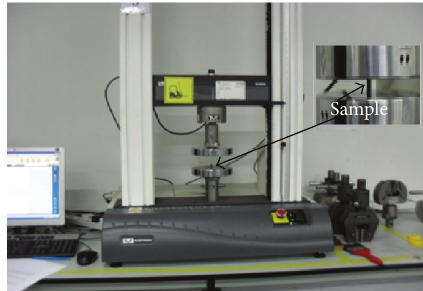
Figure 5: Hitachi scanning electron